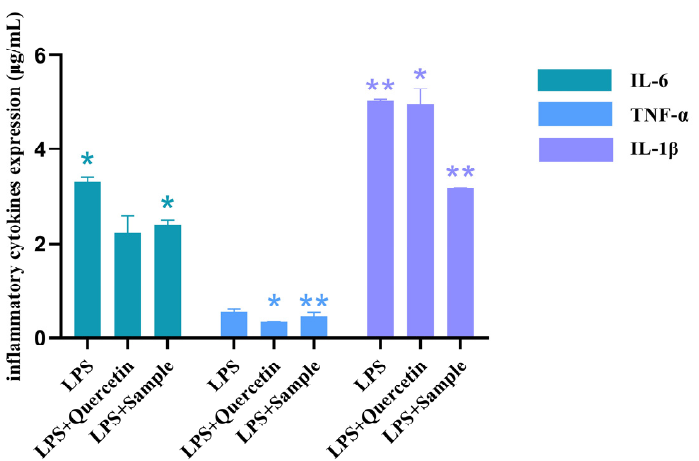
Figure 6. Effects of cloverleaf on the expression of inflammatory factors in a LPS-induced cell model Figure 6. E ff ects of cloverleaf on the expression of in fl ammatory factors in a LPS-induced cell model (* p < 0.005, ** p < (* p < 0.005, ** p < 0.001). Table 5. E ff ect of T. hemsleyanum on IL-1 β expression in the LPS-induced RAW264.7 in fl ammation model ( n = 3, * p < 0.05, ** p < 0.01).